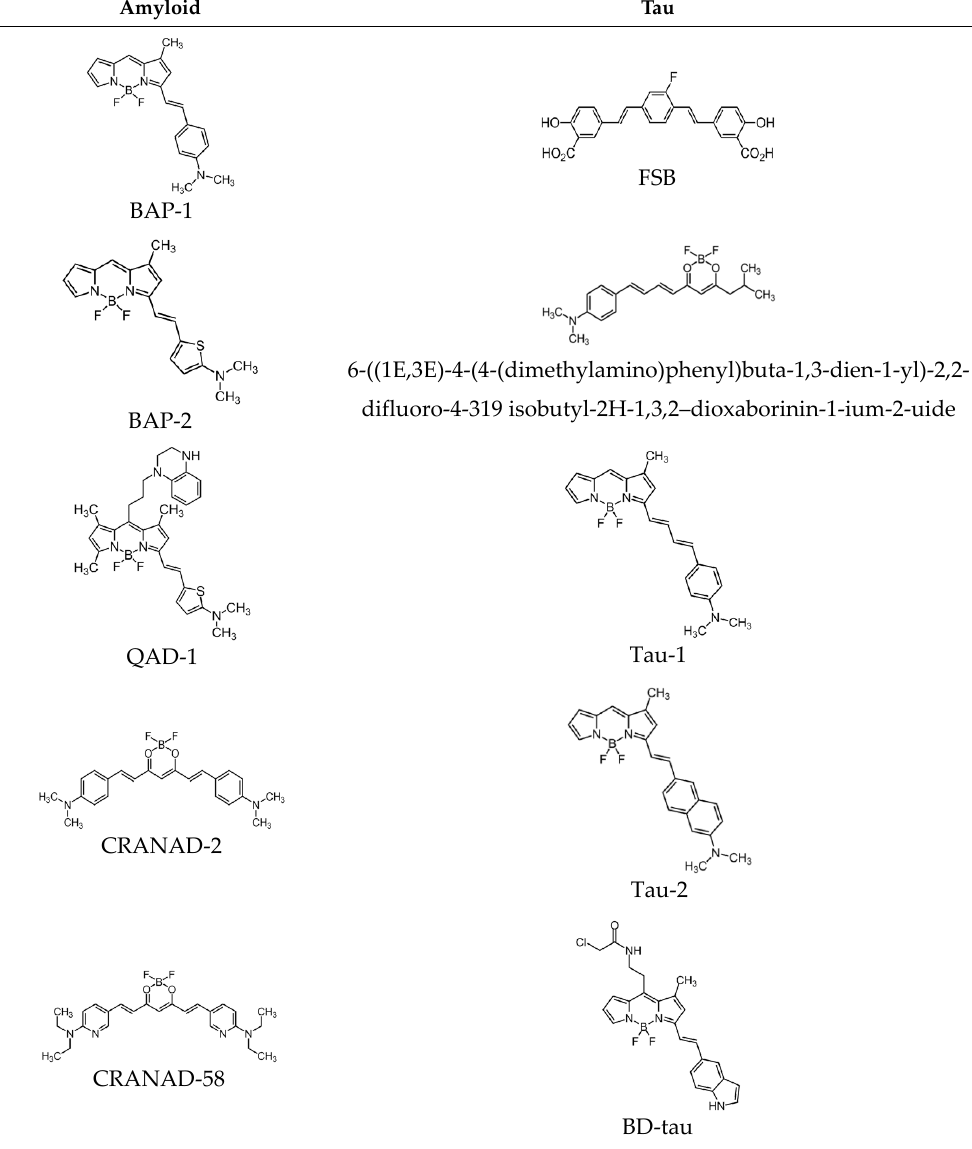
Table 3. Molecular probes for the detection of A β or NFTs using fluorescence. BAP: BODIPY-based A β aggregates.